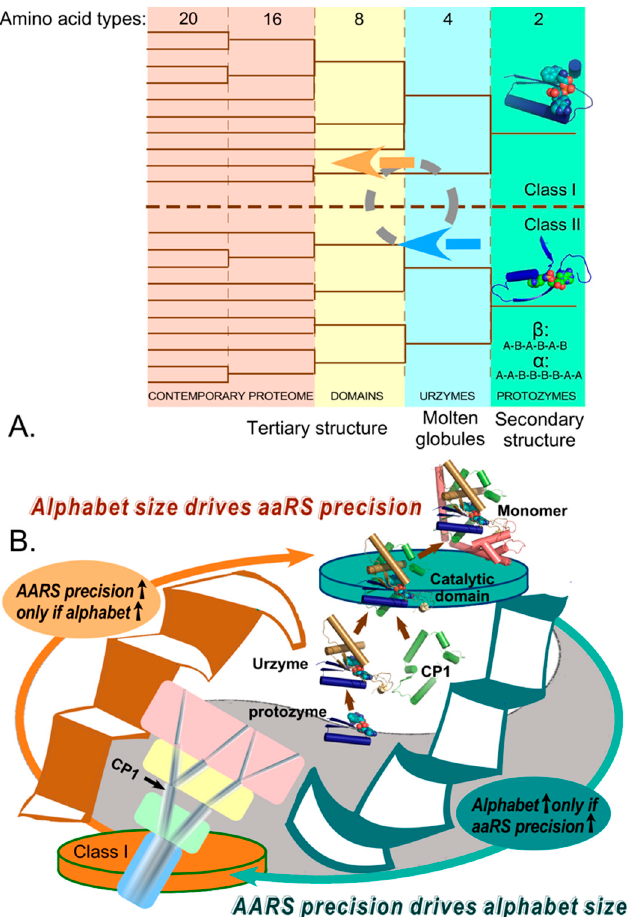
Figure 7. The strange loop connecting the proteome itself to the genetic coding table, via the precision of the aaRS and the coding alphabet size. ( A ). Stages in the evolution of the genetic coding alphabet (vertical panels; number of amino acid types) appear to be associated with the evolution of the proteome (bottom), beginning with the introduction of binary patterns enabling secondary structure formation (aaRS protozymes shown as cartoons) through intrinsically disordered molten globules (Urzymes), and finally unique tertiary structures [121]. Trees are represented by thin lines, and major increases in the size of the coding alphabet are represented in differently-colored panels. The circular symbol represents the remodeling of sequences that becomes necessary each time the number of distinct amino acid types increases. That sequence re-shuffling, optimizes in turn the precision of both new and extant aaRS genes, consistent with the new alphabet. ( B ). The reciprocally-coupled gating strange loop that drives increases in the alphabet size and aaRS